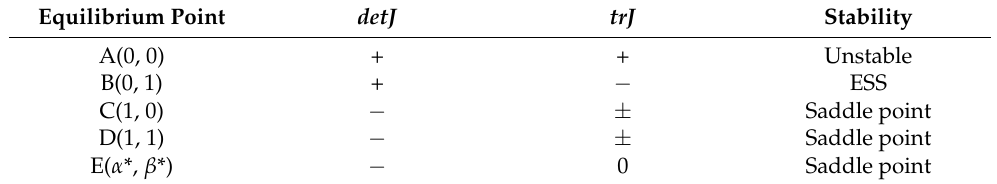
Table 3. Local stability analysis of scenario 1 between local government and coal-related enterprises. Equilibrium Point